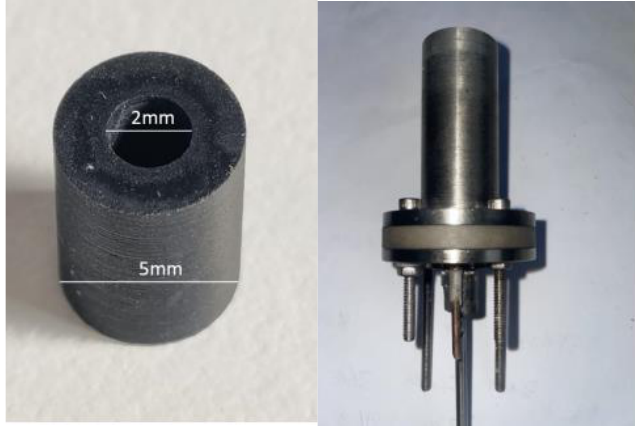
Figure 1. C12A7 emitter and C12A7 hollow cathode.